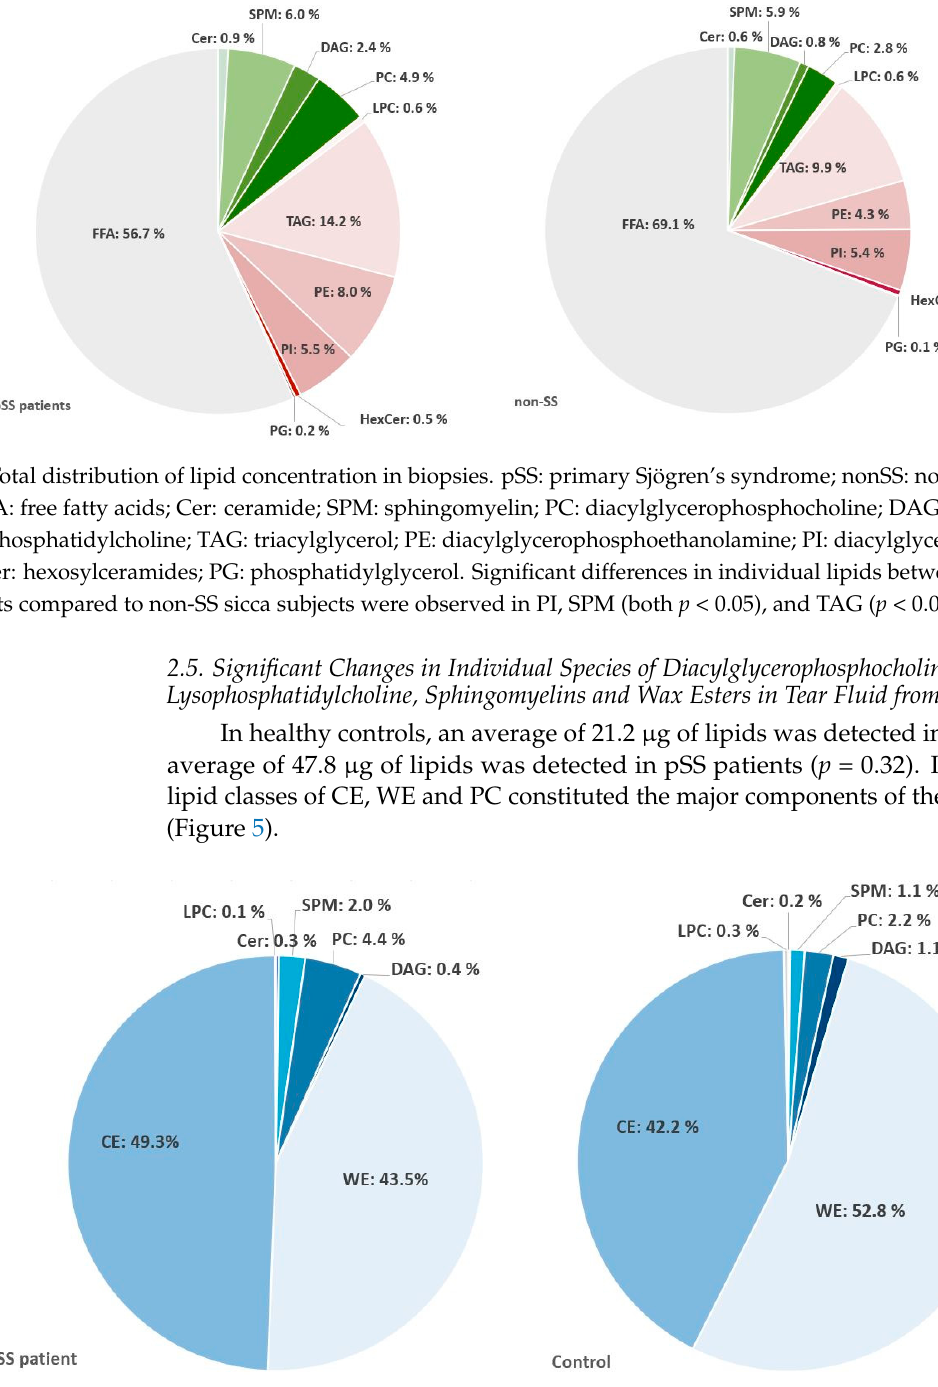
Figure 5. Lipid composition of tears. pSS: primary Sjögren’s syndrome; Cer: ceramide; SPM: sphingomyelin; PC: diacylglycerophosphocholine; DAG: diacylglycerol; WE: wax ester; CE: cholesterol ester; LPC: lysophosphatidylcholine. Significant changes between pSS patients and controls in individual species of PC, LPC, SPM and WE were found ( p < 0.01 for PC, p < 0.05 for the remaining).